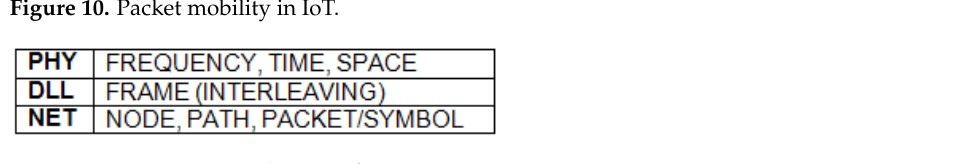
Figure 11. Layer-wise packet